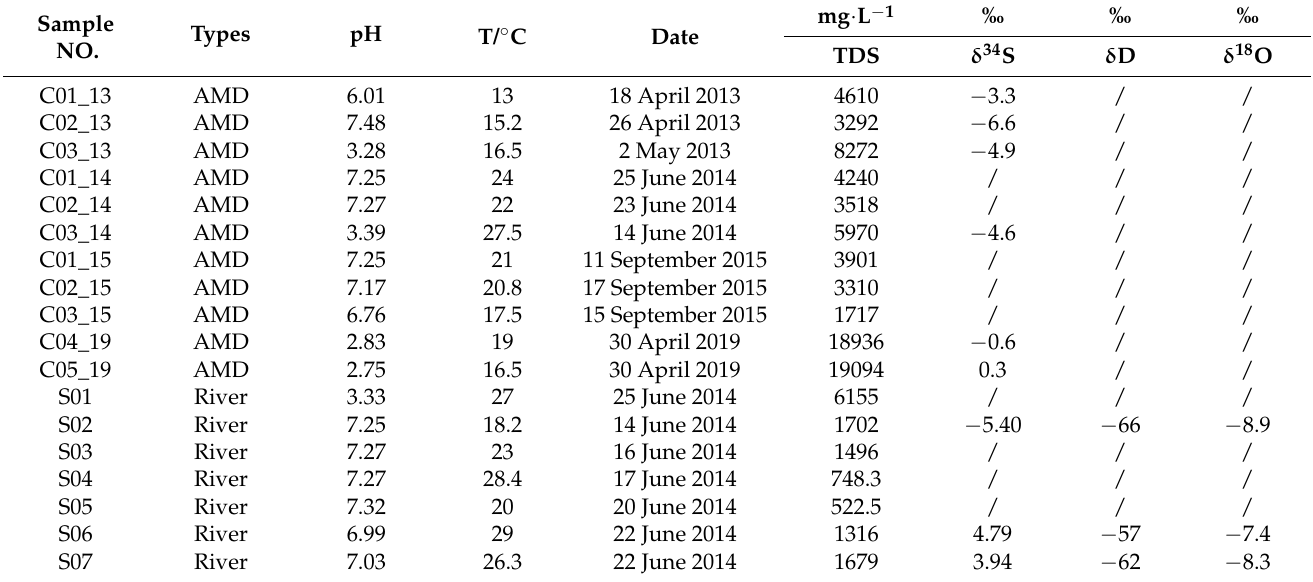
Table 2. The stable isotopes of AMD and River samples.